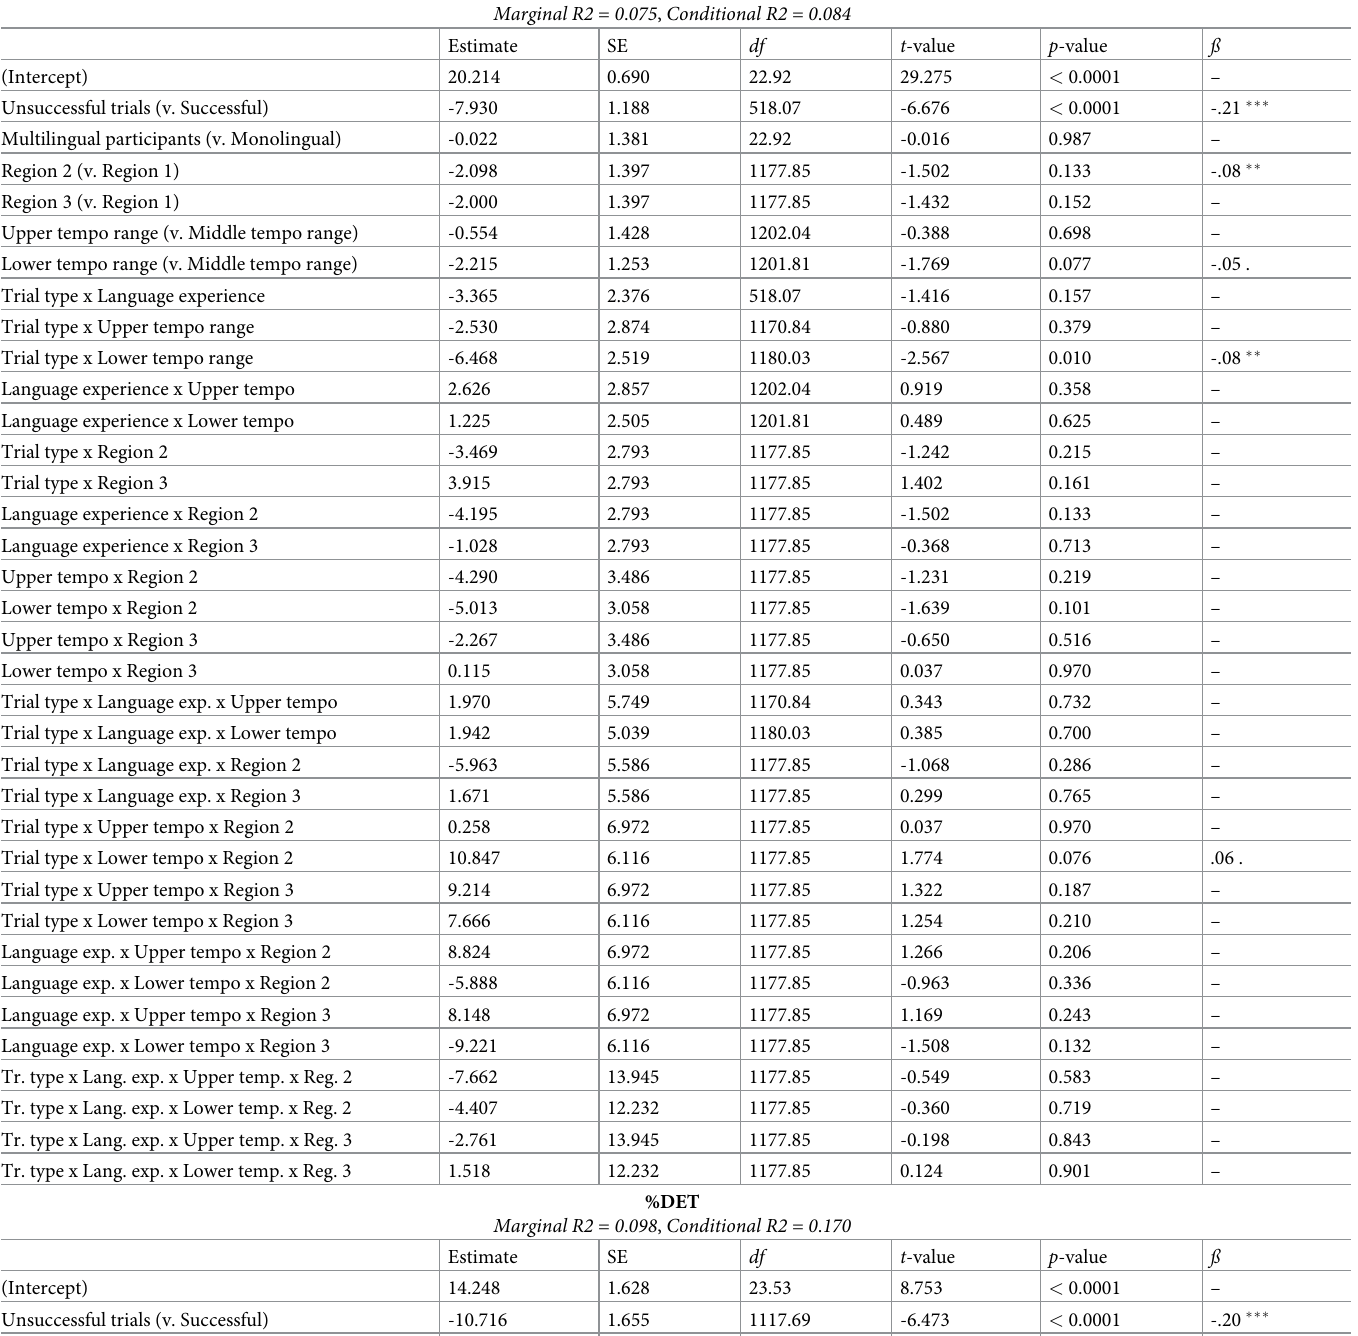
Table 4. Linear mixed effect model results for region-based MdRQA with trial type, language experience, tempo range, and region as predictors of %REC, %DET, and MAXL. Each MdRQA metric was predicted using a separate model. Marginal and conditional R 2 for each model included below each model label. Effect sizes pro- vided as standardized estimates ( ß ) for statistically significant predictors. As noted in the Model Specifications section, the use of deviation coding yields k -1 variables that test the difference between a given level of the categorical variable and the reference level. Region-based MdRQA models used the successful trials, monolingual language experience, middle tempi, and region 1 as reference categories; for more on mathematical interpretation of deviation-coded interaction terms, see Barr et al. (2013)